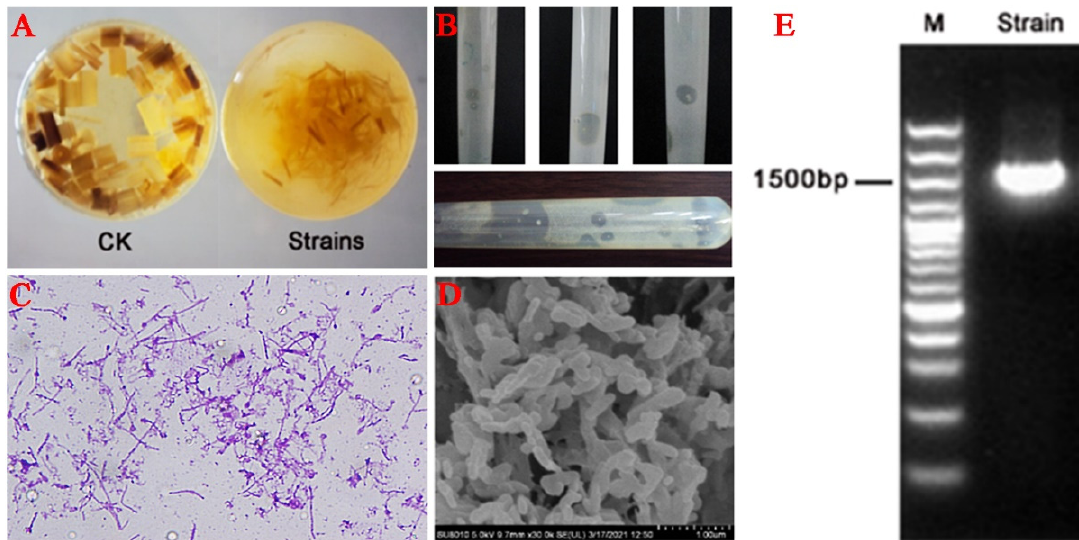
Figure 1. High-efficiency cellulose degrading sugar-producing strain: ( A ). Changes in straw fermen- tation medium before and after degradation (CK: straw fermentation medium without compound bacteria, Strains: straw fermentation medium with compound bacteria); ( B ). Hydrolysis circles formed in microcrystalline cellulose rolling tube of FC811; ( C ). Morphology of gram-stained cells of XF811; ( D ). SEM image of FC811; ( E ). Electrophoresis of PCR products of FC811 strain. Table 2. Degradation of crystalline cellulose and yield of reducing sugar Strain